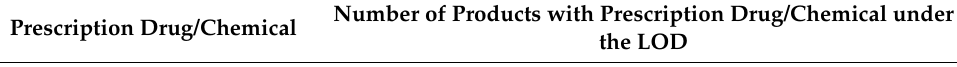
Table 2. Distribution of weight loss supplements that contained the tested prescription drugs and chemicals below the limit of detection ( n = 137).